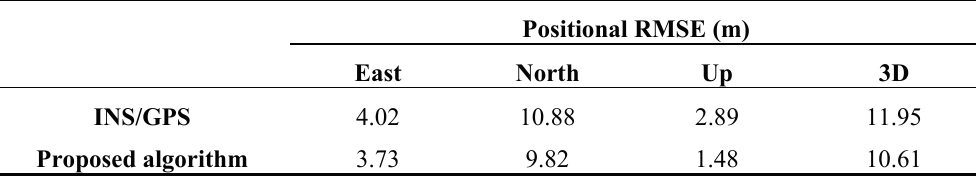
Table 3. The statistical analysis of positional errors for airborne